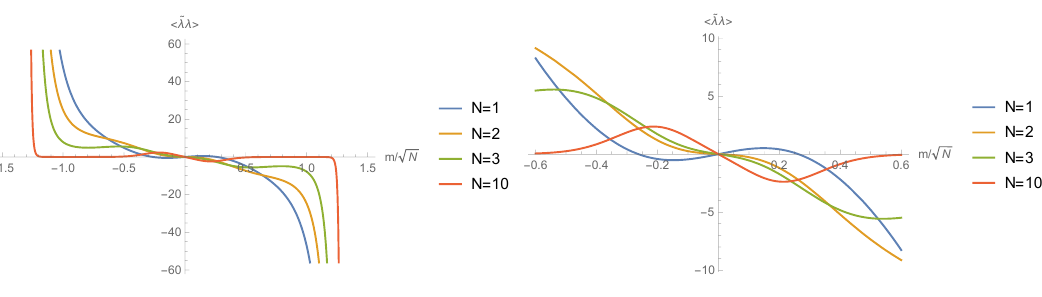
Figure 4 . For a deformation corresponding to turning on a bulk pseudoscalar (cid:12)eld, < ~ (cid:21)(cid:21) > [ m